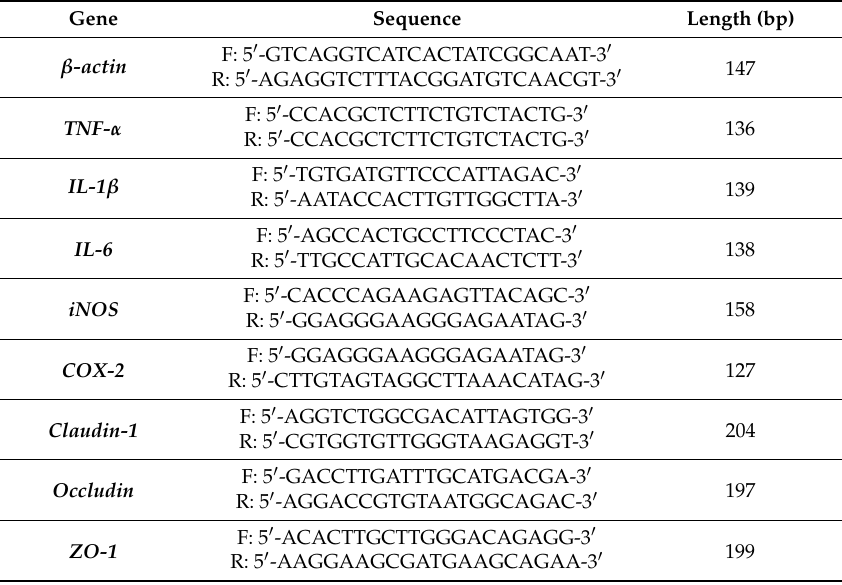
Table 2. Primers used for quantitative real-time